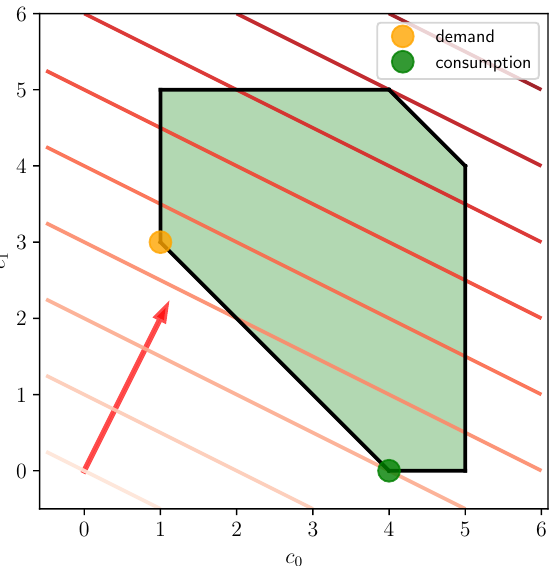
Figure 2. RTP in a simplified flexibility region (shaded region). The arrow depicts the price vector π . The contour lines of the cost function are orthogonal to the price vector. The resulting optimal consumption (dark dot) always lies at the boundary of the flexibility